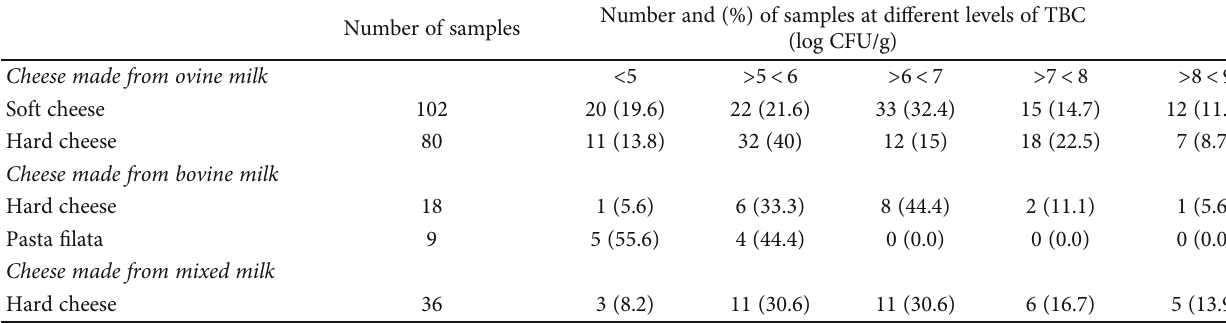
Table 1: Total bacterial count of cheese samples according to cheese categories. Number of samples